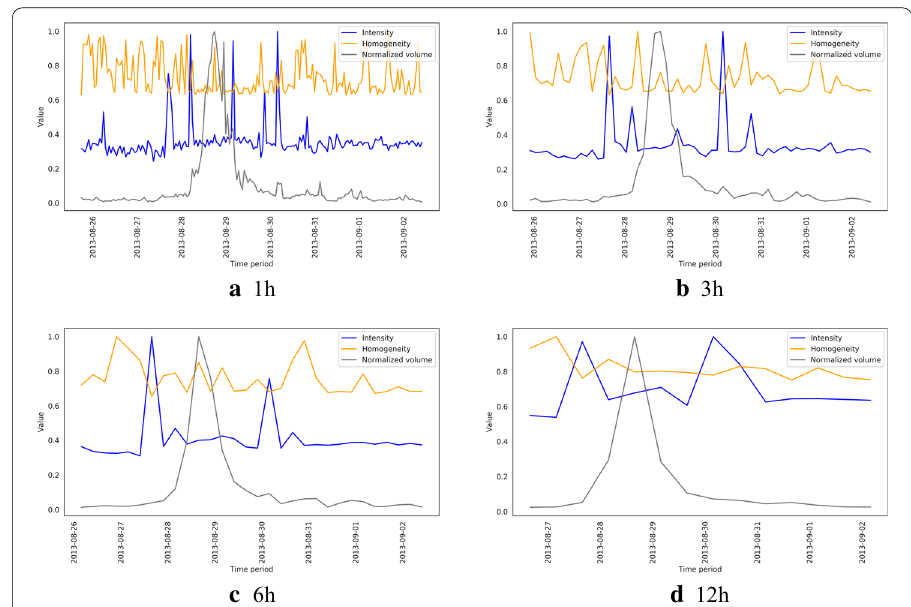
Fig. 25 Different sizes of time windows for the MLKing2013 data set